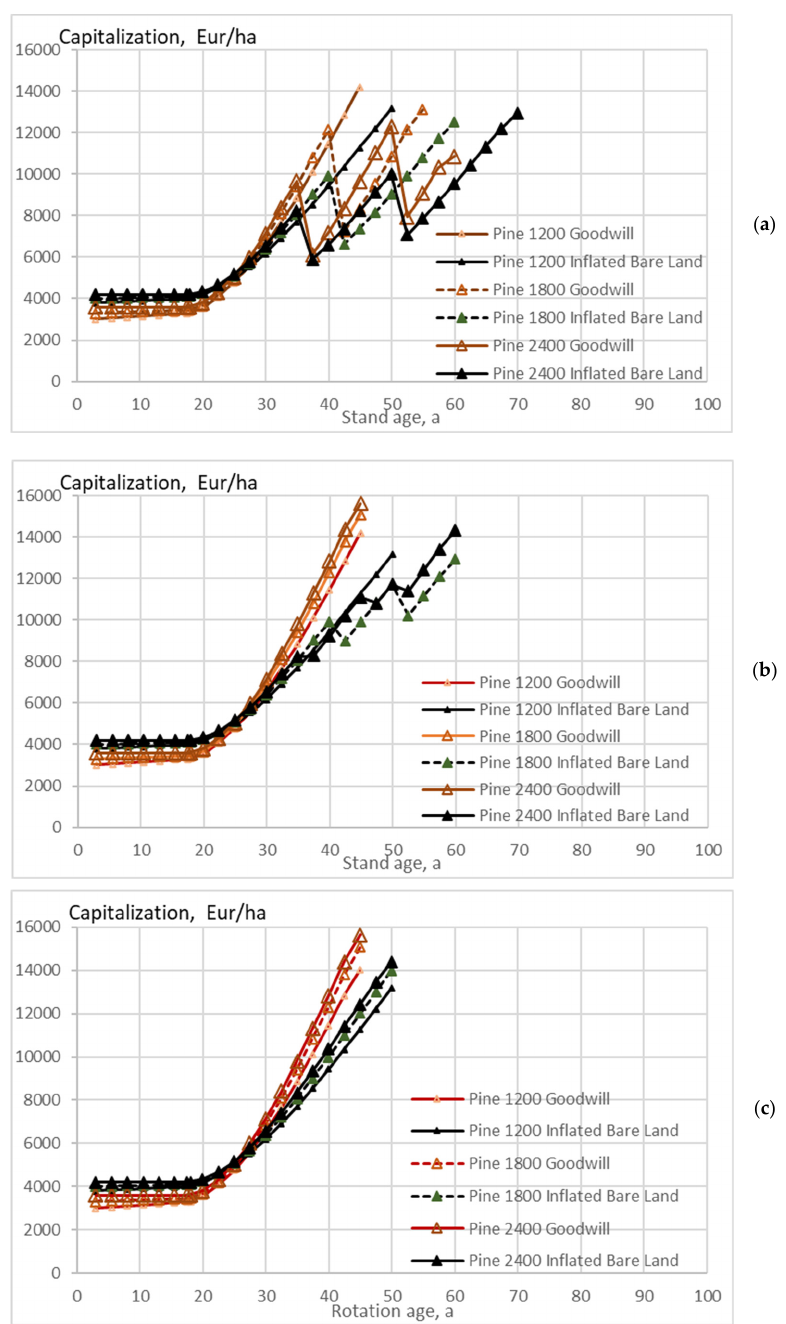
Figure 8. Capitalization on pine stands of different initial sapling densities, as a function of stand age, when the growth model is applied as early as applicable, without any thinning restriction ( a ), and in good-quality trees of at least 238 mm of diameter only removed in thinning ( b ), and without any commercial thinning ( c ). Inflated capitalization is introduced either as proportional goodwill or as inflated bare land value.